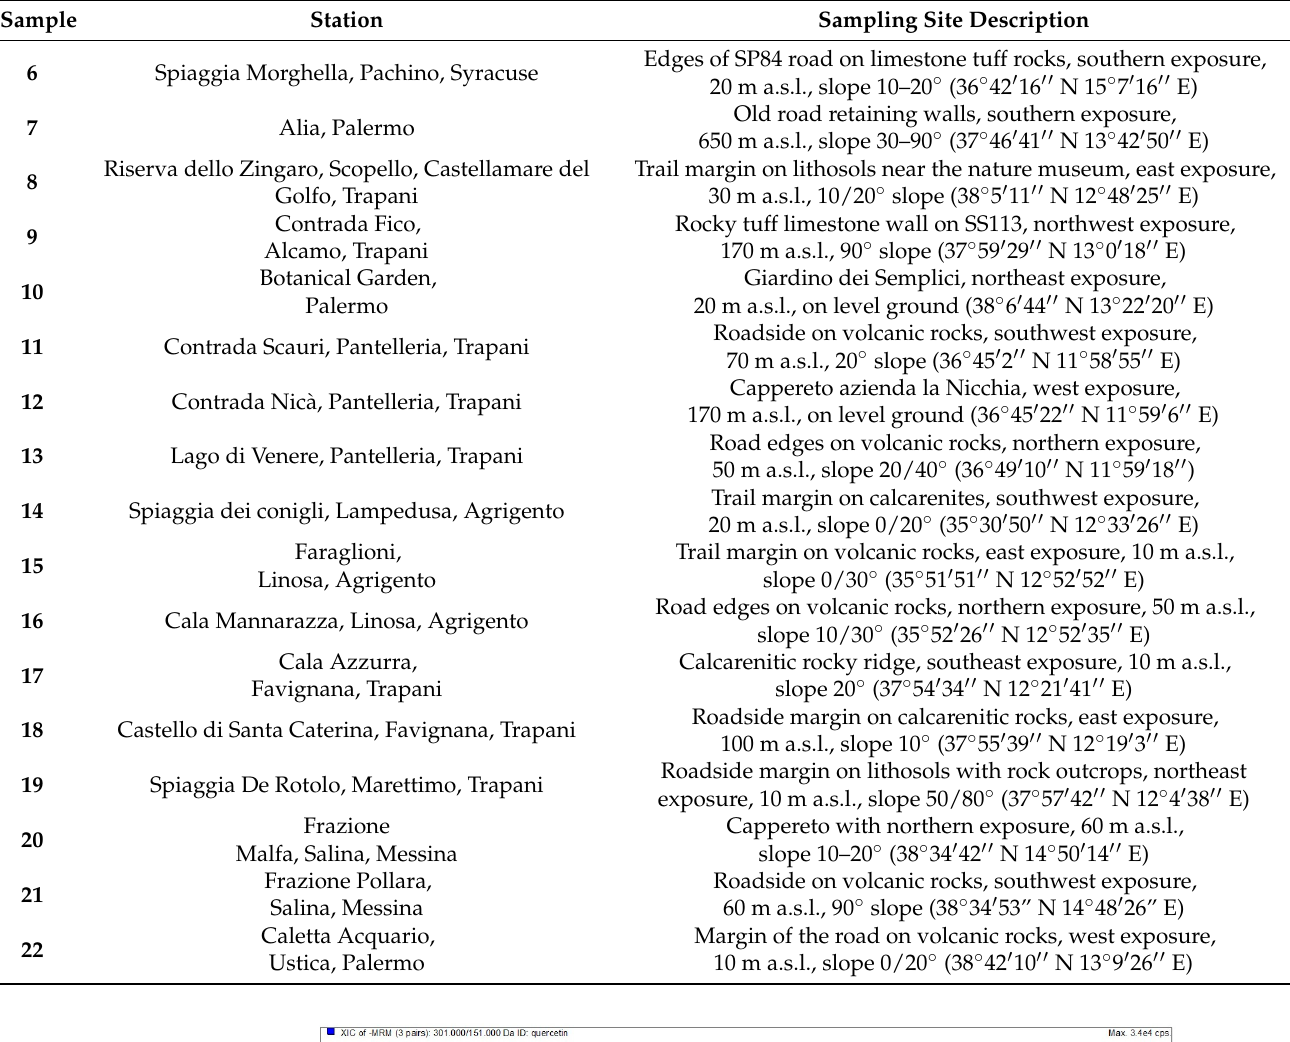
Table 2. C. orientalis sampling site description.